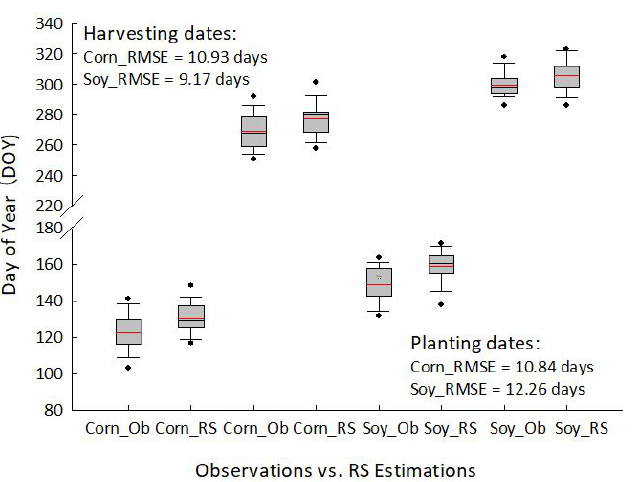
Figure 4. Comparison between the estimated and observed crop phenology at the county level (Red line represents the mean values of each group; Black points represent the values of 5th and 95th of each group; Corn_Ob and Soy_ob represent phenological observations from field tests; Corn_RS and Soy_RS represent phenological estimations from remote sensing).